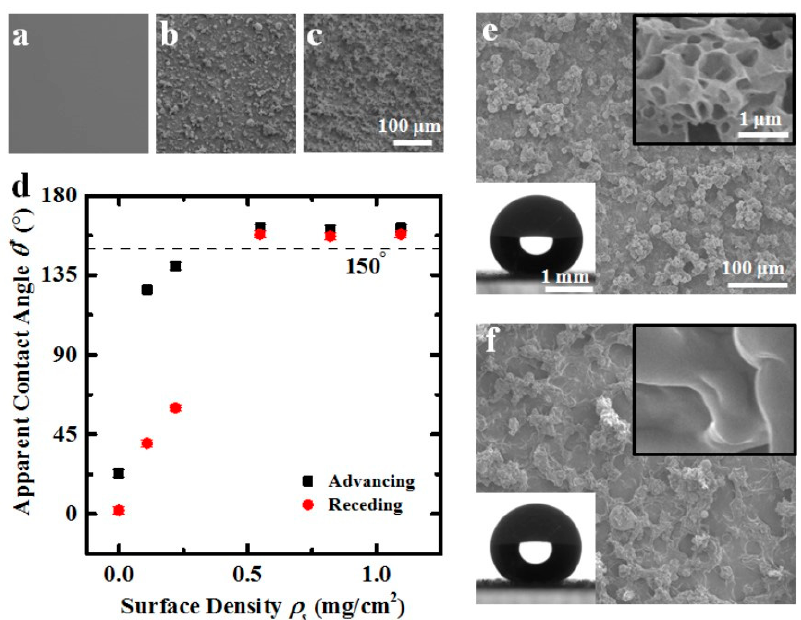
Figure 5. ( a – c ) Glass slide coated with 0, 0.2, and 0.55 mg cm –2 emulsion, respectively. ( d ) Advancing and receding apparent contact angles of water on a glass slide coated with varying ρ s of carnauba wax. The surface becomes superhydrophobic when ρ s ≳ 0.55 mg cm –2 . ( e , f ) Scanning electron microscope (SEM) images of glass slides coated with 0.55 mg cm –2 of carnauba wax and 1.1 mg cm –2 of beeswax, respectively. The upper right inset of each frame shows a higher magnification image of the microscale structures and the lower left inset shows θ * > 150° for both coating materials. Reprinted with permission from [55] 2016 ACS Publications .